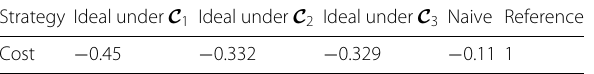
Table 3 Normalized average opex for the ideal (with and without SOC constraints), naive , and reference